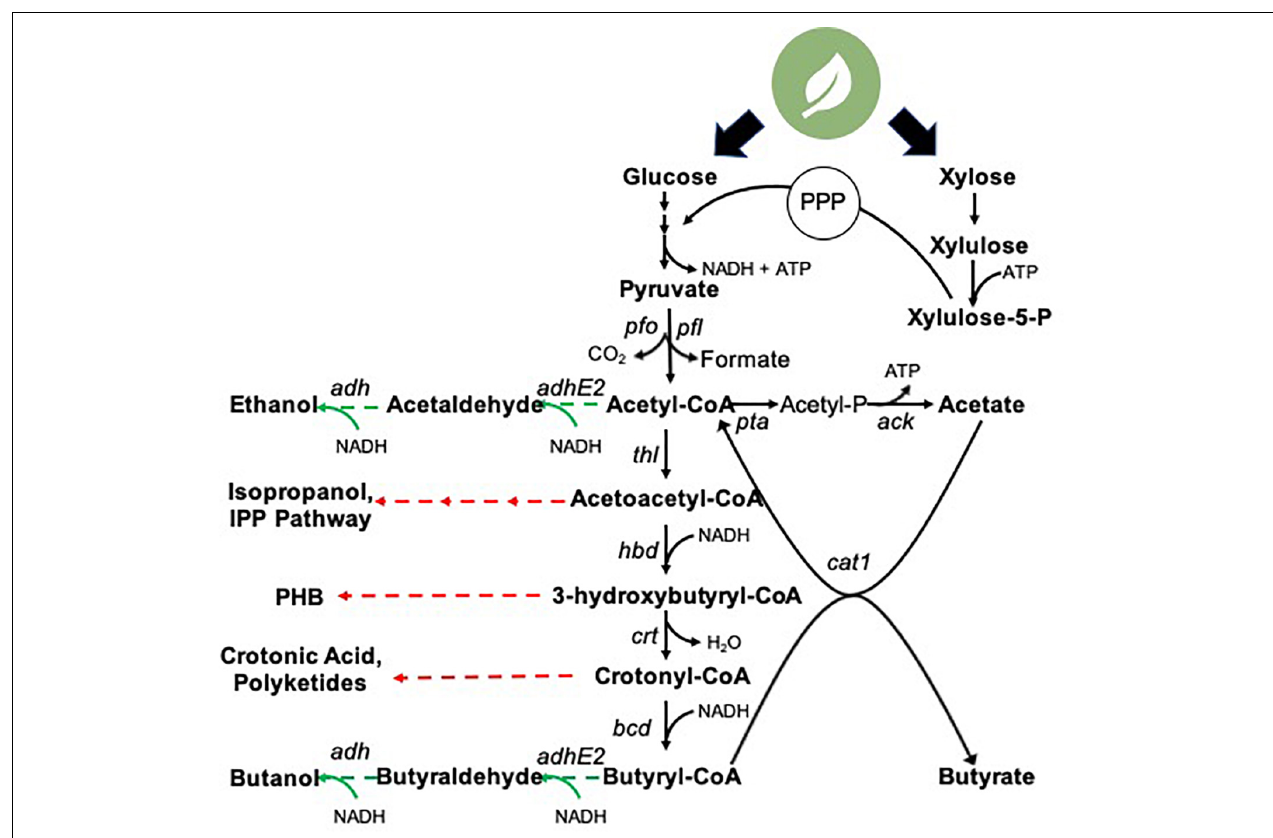
FIGURE 2 | Clostrium tyrobutyricum central carbon metabolism and biosynthetic potential. Black arrows: known biosynthetic pathways native metabolic intermediates. Green arrows: heterologous genes successfully expressed in C . tyrobutyricum for the production of non-native products. Red arrows: unexplored production routes in C . tyrobutyricum. pfo, pyruvate:ferredoxin oxidoreductase; pfl, pyruvate:formate lyase; pta, phosphotransacetylase; ack, acetate kinase; thl, thiolase; hbd, 3-hydroxybutyryl-CoA dehydrogenase; crt, 3-hydroxybutyryl-CoA-dehydratase; bcd, butanoyl-coA dehydrogenase; cat1, butyrate:acetate CoA transferase; thi, thioesterase; adh, alcohol dehydrogenase; adhE2, aldehyde-alcohol dehydrogenase; PHB, polyhydroxybutyrate; IPP, isoprenoid